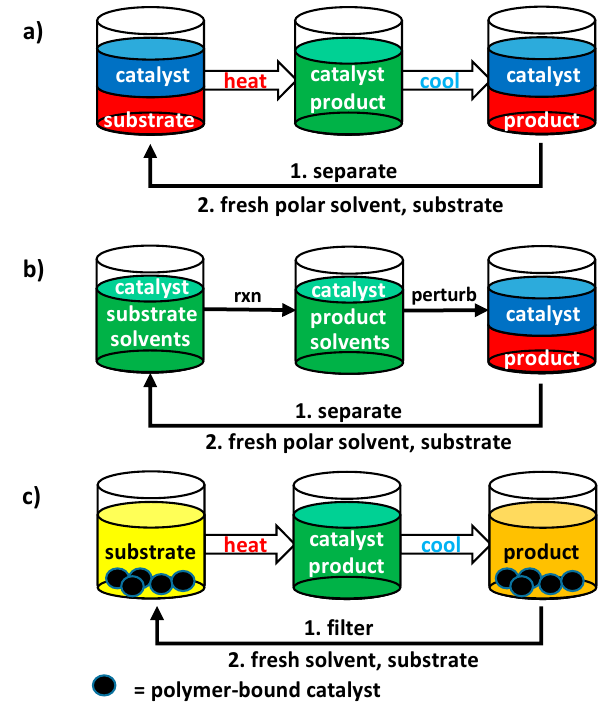
Figure 9. Schematic representation of ( a ) thermomorphic liquid/liquid separation where a biphasic mixture of polar and nonpolar solvent is heated to form a miscible solvent mixture ; ( b ) a latent biphasic liquid/liquid separation where a room temperature mixture of miscible solvents is used to effect a reaction and the solvent mixture is perturbed (e.g., by addition of another solvent (e.g., water) or some salt) to form a separable biphasic mixture of polar and nonpolar solvents; and ( c ) a thermomorphic solid/liquid separation system where a mixture of substrate and insoluble polymer-bound catalyst is heated to form a monophasic solution that is in turn cooled to form a precipitate of the polymer bound catalyst that is then separated from the product solution by filtration.